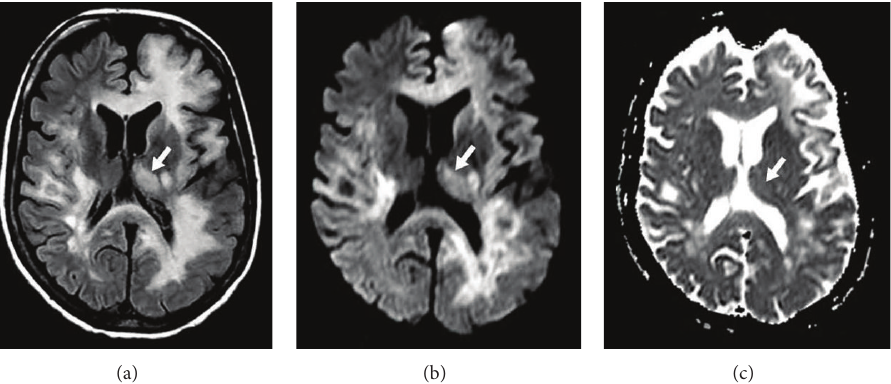
Figure 22: Diffuse white matter and associated left frontal cortical and left thalamic (arrows) involvement seen as hyperintensity on FLAIR (a), DWI (b), and ADC map (c) in a patient with natalizumab-related (for multiple sclerosis) progressive multifocal